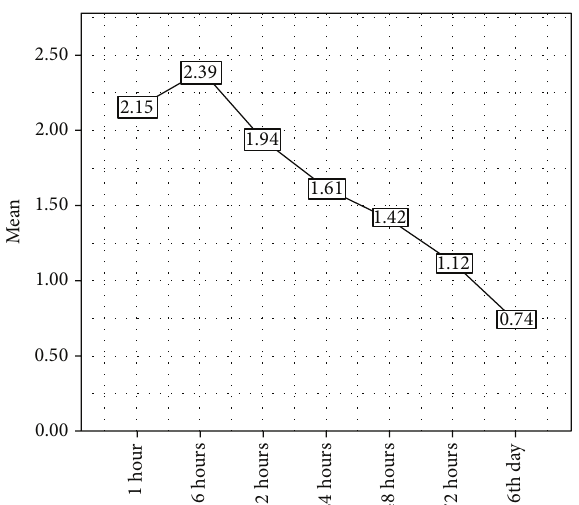
Figure 5: Overall pain trend over 6 days in both